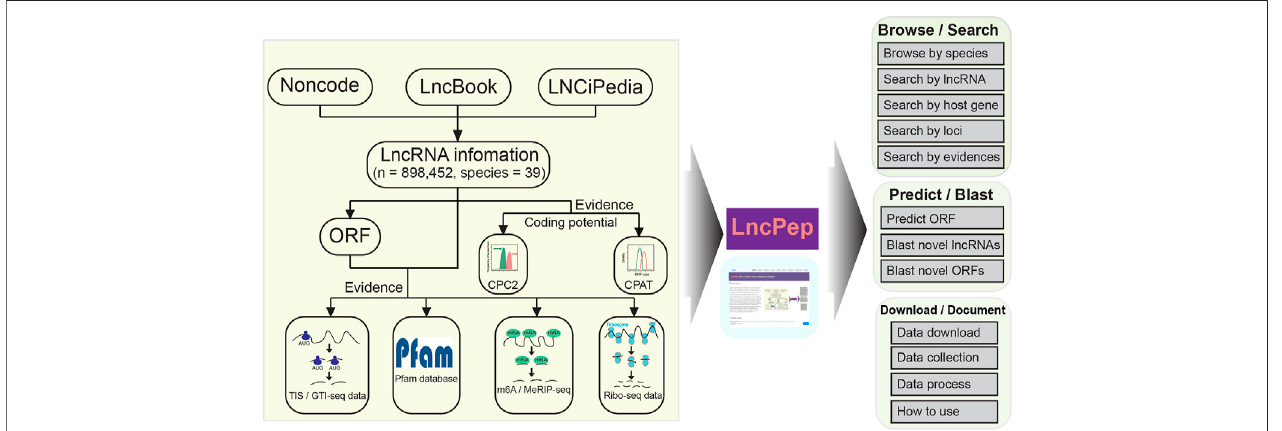
FIGURE 1 | Data curation and construction pipeline of the LncPep database. LncPep collects lncRNA information from NONCODE, LncBook, and LNCipedia, including898,452lncRNAs across39differentspecies.The peptide-translatingpotentialofalllncRNAs wasevaluated by fi vedifferenttools/resources,including CPC2, CPAT, m6A, Ribo-seq, and TIS. The major functions of LncPep include Browse, Search, Predict, Blast, Download, and Document.